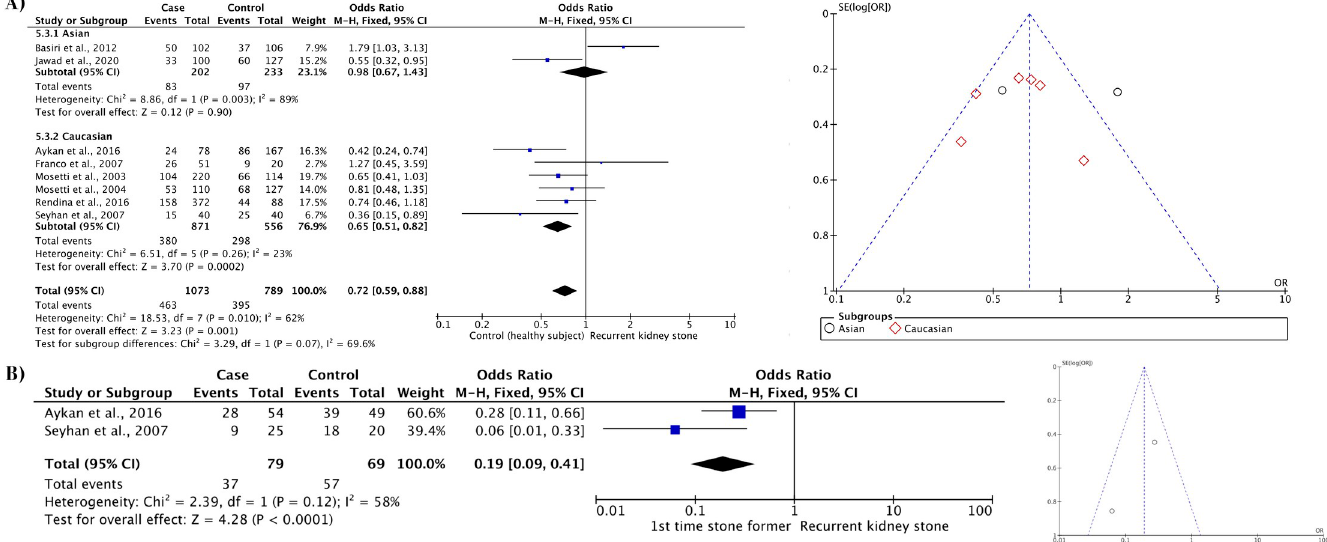
Fig 5. Forest and funnel plots of the VDR TaqI polymorphism. A) TaqI polymorphism (heterozygous model) with healthy subject groups as controls. B) Sub– analysis of the TaqI polymorphism (homozygous model) among Caucasians with first–time stone formers as controls.